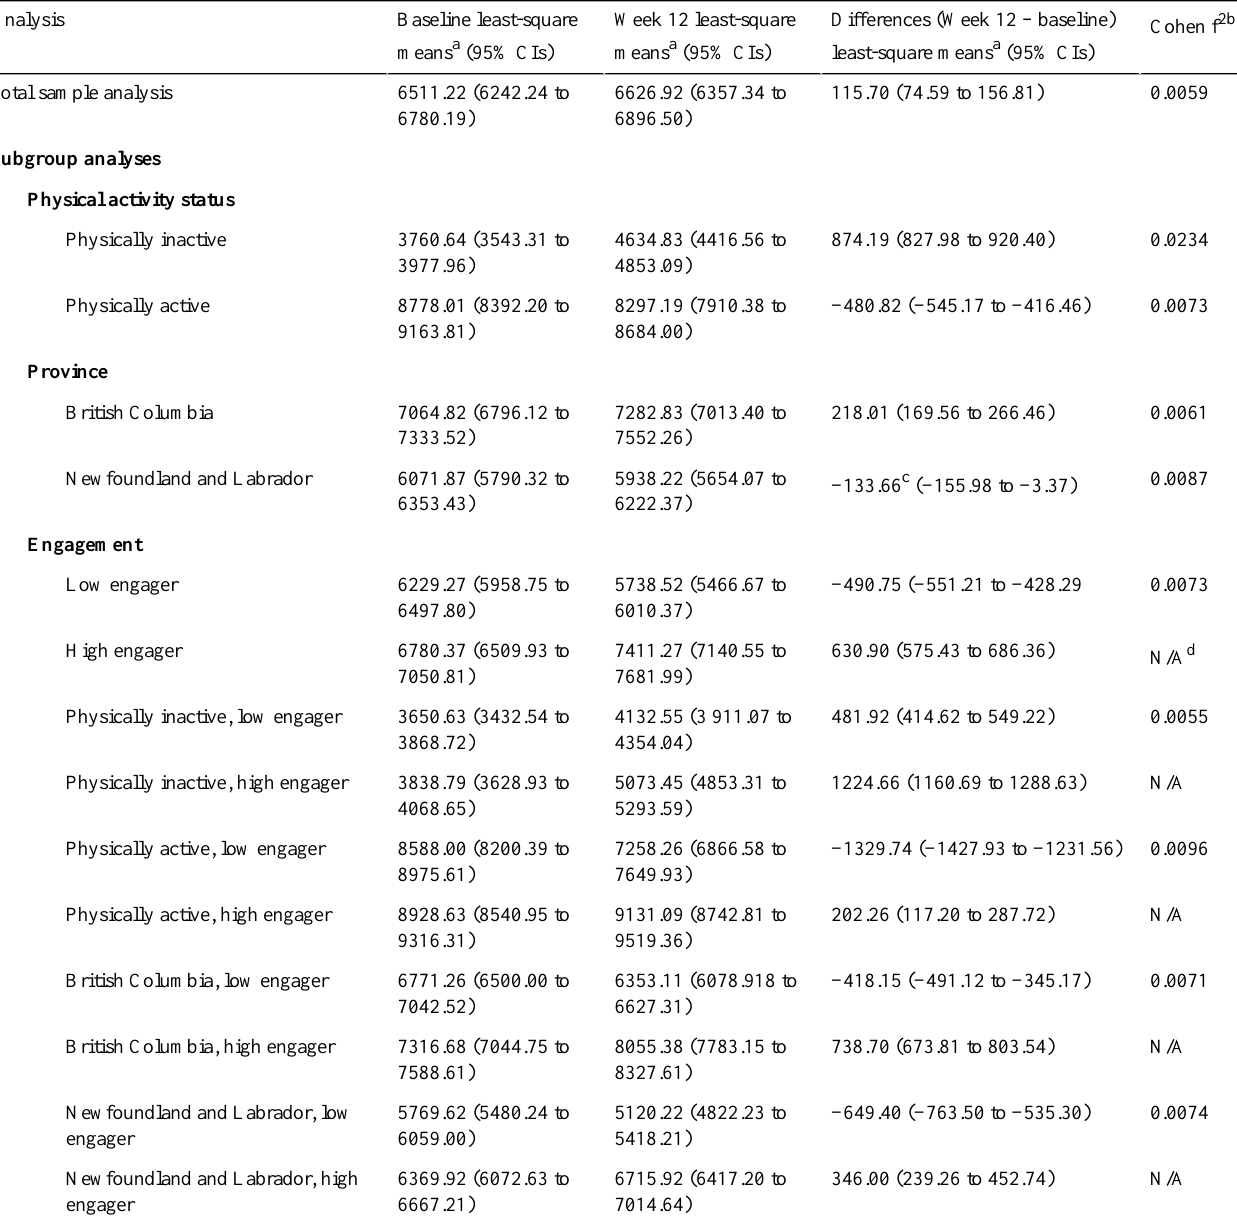
Table 2. Changes in mean daily step counts between baseline and study week